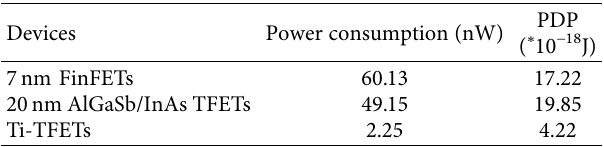
Figure 11: Majority-Not logic cell. (a) Truth table, (b) the traditional “Majority-Not” cell using static complementary CMOS logic, (c) a realization using NAND, NOR, and MUX with a select signal S , and (d) the logic cell using Ti-TFETs. Table 3: The power consumption and power delay product of static complementary Majority-Not cell using FinFETs, single gate TFETs, and